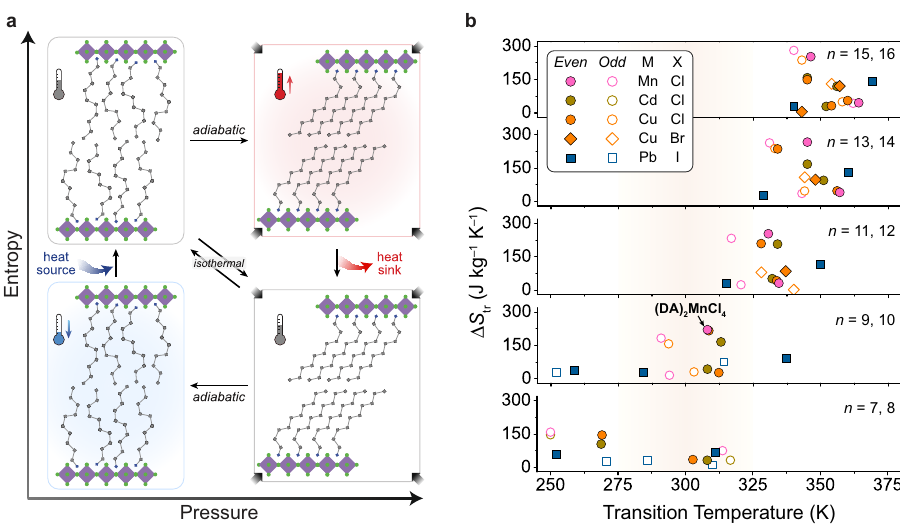
Fig. 1 Barocaloric cooling with two-dimensional (2-D) metal – halide perovskites. a Illustration of how the pressure dependence of hydrocarbon order – disorder transitions in the organic bilayers of hybrid 2-D perovskites can be leveraged to drive a barocaloric cooling cycle. Each cooling cycle begins with an adiabatic (Brayton-like cycle) or isothermal (Stirling-like cycle) increase in pressure that induces a fi rst-order phase transition from an expanded, high-entropy phase of the 2-D perovskite to a contracted, low-entropy phase. Heat released during this exothermic transition is dissipated to a heat sink, returning the material to its original temperature but now at a lower entropy. The pressure is then adiabatically or isothermally decreased to reverse the phase transition and cool a heat source. b Comparison of phase transition entropies, Δ S tr , and transition temperatures, T tr , for order – disorder transitions in select 2-D perovskites of the form (C n H 2 n + 1 NH 3 ) 2 MX 4 ( n = 7 – 16; M = Mn, Cd, Cu, or Pb; X = Cl, Br, or I). Thermally induced phase transitions in 2-D perovskites are often accompanied by large changes in entropy that are sensitive to the length of the hydrocarbon chain and the identity of the metal and halide in the inorganic layer. Many of these order – disorder transitions involve one or more minor transitions that occur at lower or higher temperatures than the major transition, but (DA) 2 MnCl 4 (DA = decylammonium) features a single order – disorder transition with a large entropy change near ambient